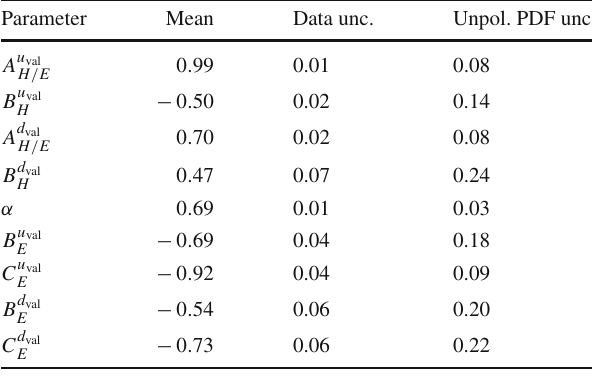
Table2 ValuesofparametersfittedtoEFFdatatogetherwithestimated uncertainties coming from those data and used PDF parameterizations Parameter Mean Data unc. Unpol. PDF